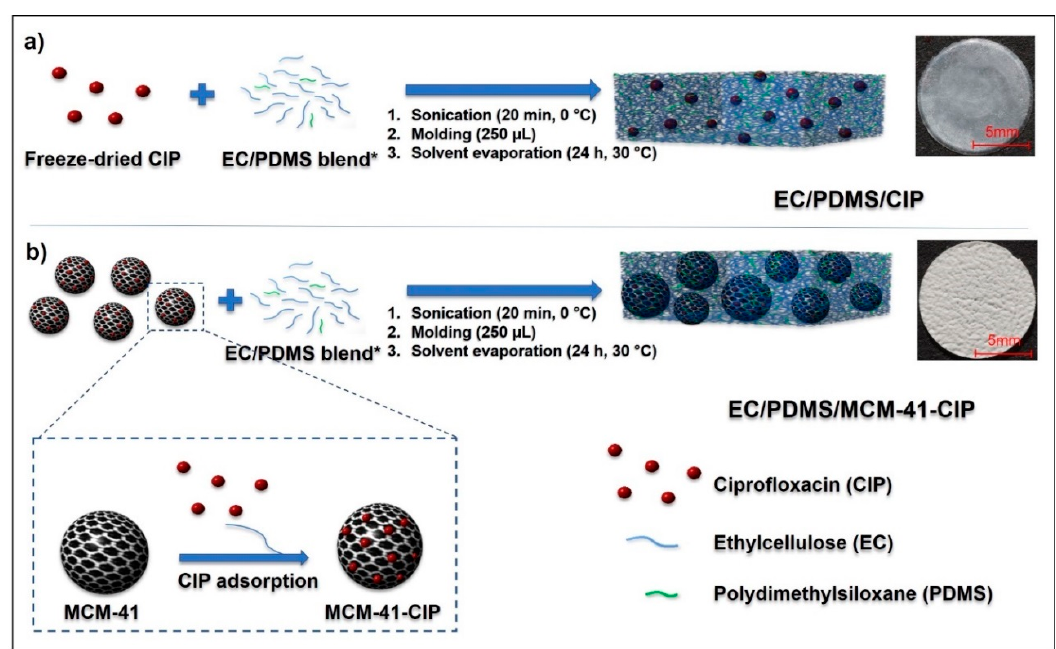
Scheme 1. Schematic diagram of consecutive stages of the composite fabrication. Composites Scheme1. Schematic diagram ofconsecutive stages of the composite fabrication. Composites containing containing freeze-dried CIP: EC/CIP, EC/PDMS/CIP ( a ); Composites containing MCM-41-CIP: freeze-dried CIP: EC / CIP, EC / PDMS / CIP ( a ); Composites containing MCM-41-CIP: EC / solution (5% ( w / w )) was used instead of EC/PDMS blend. Table 1. The qualitative and quantitative composition data of composites.